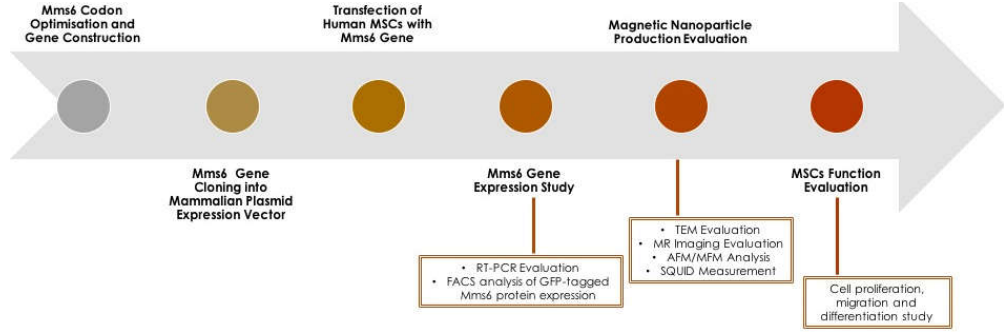
Figure 2. Workflow for induction and assessment of magnetic nanoparticle production in human mesenchymal stem cells (MSCs) following mms6 gene transfection.